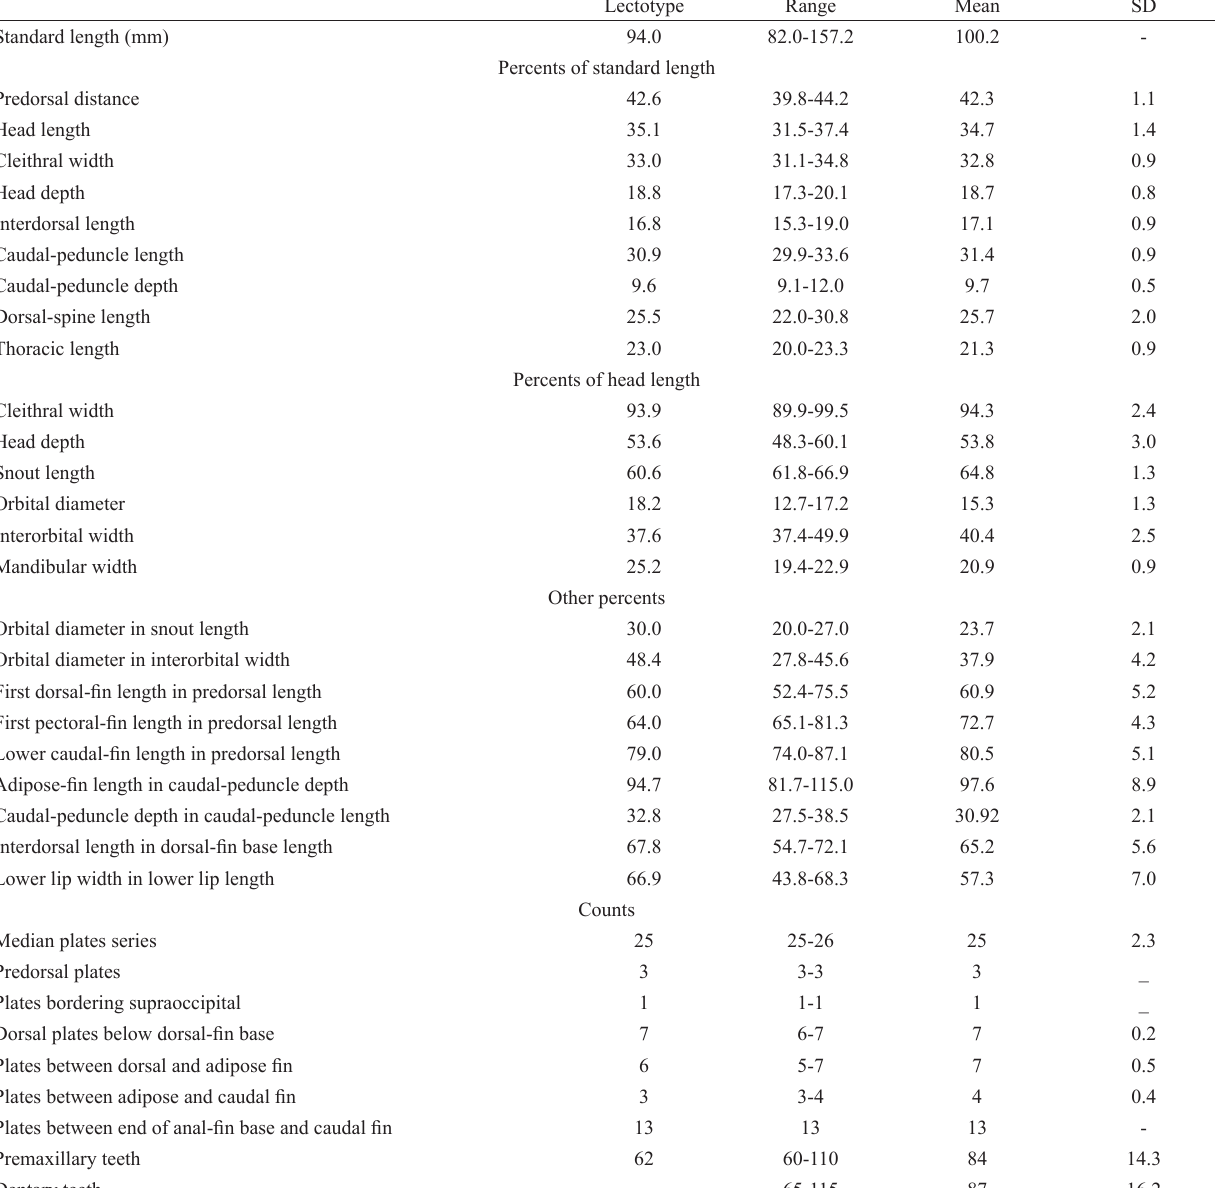
Tab. 1. Morphometric data and counts of Hypostomus johnii from the rio Parnaíba basin, Brazil. N = 22; SD, Standard